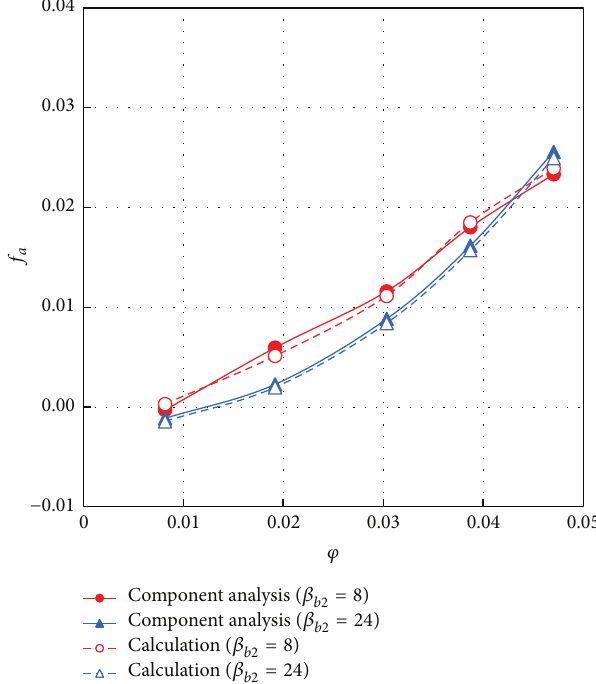
Figure 17: Time-averaged values of hydraulic part axial thrust coefficient ( 𝑓 𝑎 ) as functions of flow rate coefficient ( 𝜑